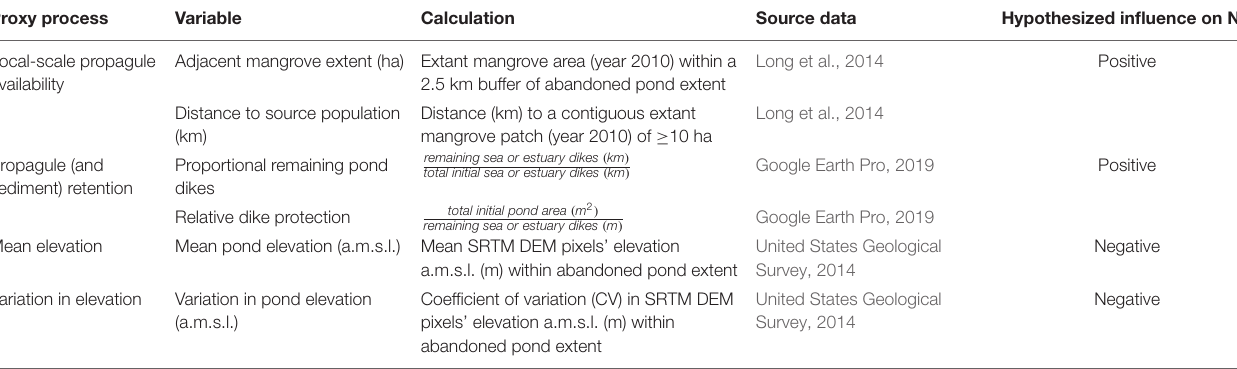
TABLE 1 | Variables employed in statistical analysis of potential drivers of natural regeneration (NR) rates in abandoned aquaculture